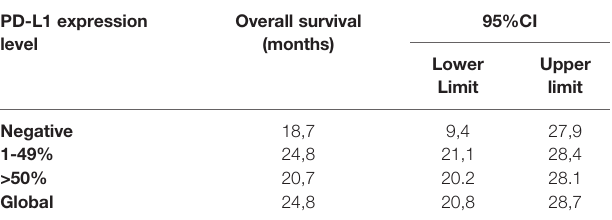
FIGURE 2 | Distribution of PDL1 expression among main genomic alterations found in Colombian patients with lung SCC. TABLE 2 | Overall Survival according to PDL1